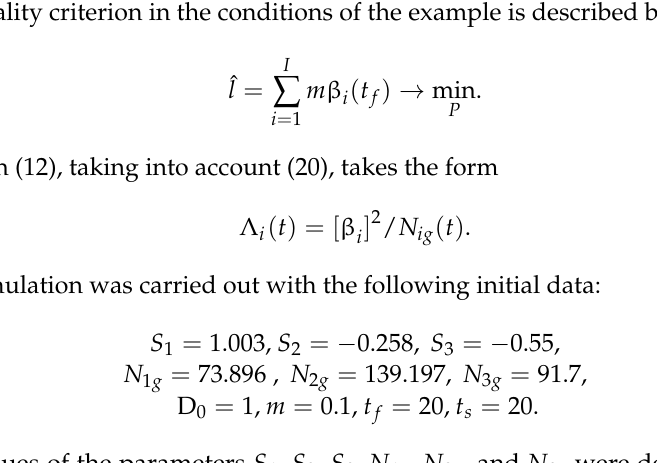
Figure 2. Models of observation of controlled objects.